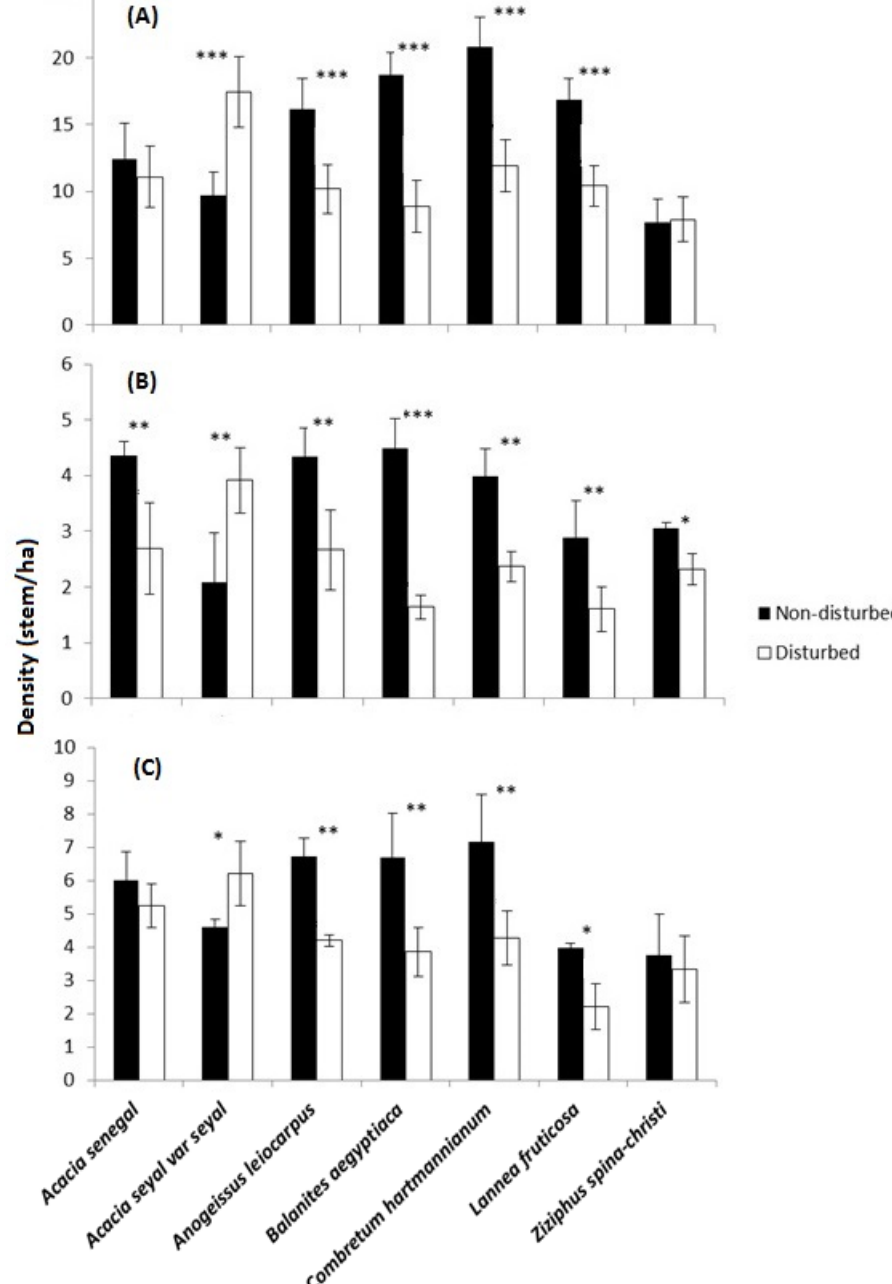
Figure 1. Average (±SE) density (stem/ha) of the seven most common tree species in the non-disturbed and disturbed sites of the Dinder Biosphere Reserve in the year of 2020. ( A ) Mature trees; ( B ) saplings; ( C ) seedlings. Asterisks above the bars show significant differences across the sites for each species according to Tukey’s Post-Hoc tests (* = p < 0.05; ** = p < 0.01; *** = p < 0.001; n = 408). Moreover, our findings showed that the proportion of the seven most common tree species were significantly different for adult trees ( F 6,404 = 22.3; p = 0.012), saplings ( F 6,404 = 31.1; p = 0.01), and seedlings ( F 6,404 = 27.6; p = 0.013) between the non-disturbed and disturbed sites, with high percentages of seedlings and saplings in the non-disturbed